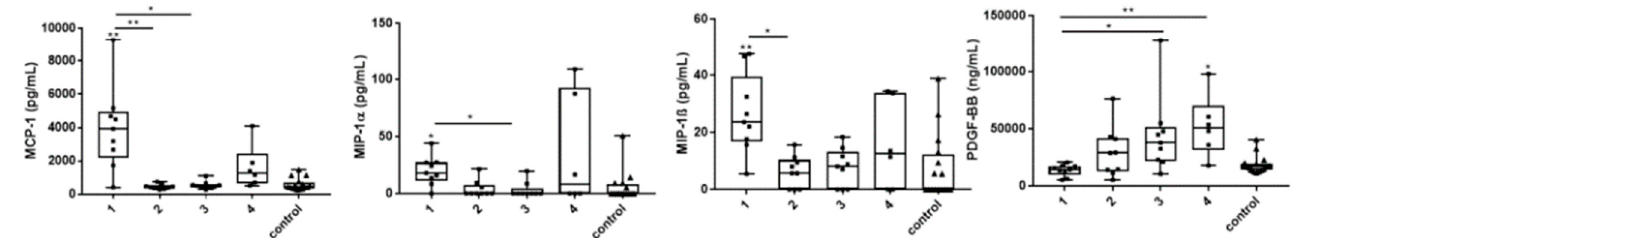
Figure 2. Changes of serum cytokine and chemokine levels in acute tularemia cases over time. Sera from nine patients diagnosed with acute tularemia and 16 sera from healthy blood donors (controls) were analyzed by bead-based LegendPlex assay. Time sampling points are shown on the X axis (1 – 3 represent 1, 2, and 3 weeks after exposure; 4 represents 21 weeks after exposure). For sampling points 1–3, sera from all nine patients for whom antibody testing was performed were available. For sampling time point 4, only sera from six patients were available. In comparison to the healthy controls and / or between di ff erent time points, significant changes of eotaxin, G-CSF, IFN α , IFN γ , IL-1 β , IL-2, IL-6, IL-8, IL-10, IP-10, MCP-1, MIP-1 α , MIP-1 β , and PDGF-BB were demonstrated in the tularemia patients. Non-significant but marked changes were seen for IL-4, IL-9, IL-12, IL-13, and IL-22. Many mediators peaked at the first sampling time point, whereas peaks at sampling time point 4 were caused by patients 3, 6, and 7. Patients 4 and 7 showed the highest cytokine and chemokine responses throughout. For comparison between the analyzed groups, the Kruskal–Wallis test with subsequent Dunn’s multiple comparisons test was used. Data are expressed as box-and-whisker plots showing median, upper and lower quartile, minimum, and maximum values. Asterisks indicate statistically significant di ff erences (* p < 0.05, ** p < 0.01, *** p < 0.001, **** p < 0.0001). Asterisks with bars represent comparisons between the respective time sampling points. Asterisks without bars represent the comparison of individual time sampling points versus the control group. Serum concentrations of FGF-basic, GM-CSF, IL-5, IL-17A, IL-17F, IL-21, RANTES, TNF α , and VEGF were similar in the patients and the controls. Generally, most cytokine and chemokine levels peaked in the first week after exposure, followed by normalization over the next weeks. Of note, some cytokines and chemokines peaked at blood sampling time point 4 instead (eotaxin, IL-4, PDGF), or showed a second peak at time point 4 (IL-1 β , IP-10, MCP-1, MIP-1 α , MIP-1 β ). This second peak seen in the patient cohort 21 weeks after exposure was mainly due to elevations of these cytokines in patients 3, 6, and 7. Patients 4 and 7 showed the highest concentrations for most cytokines and chemokines tested at the first three sampling points (high responders). In contrast, patient 9 who seroconverted later than three weeks post exposure showed generally the lowest cytokine and chemokine concentrations throughout the observation period (low